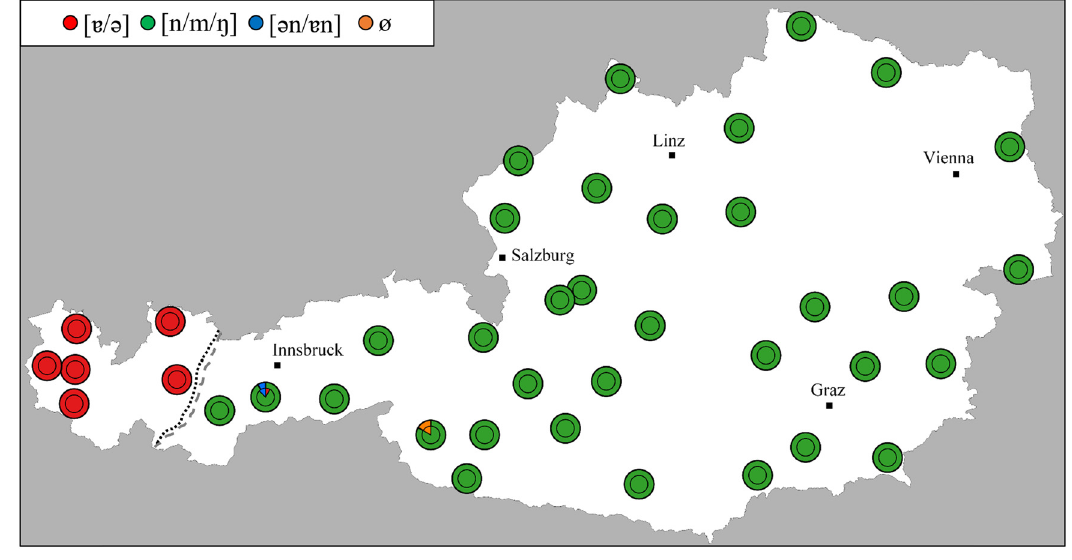
Figure 6: ( en ) following plosives, liquids, and ( post -) alveolar fricatives ( inner circles = percentage of variants realised by older speakers; outer circles = percentage of variants realised by younger speakers )